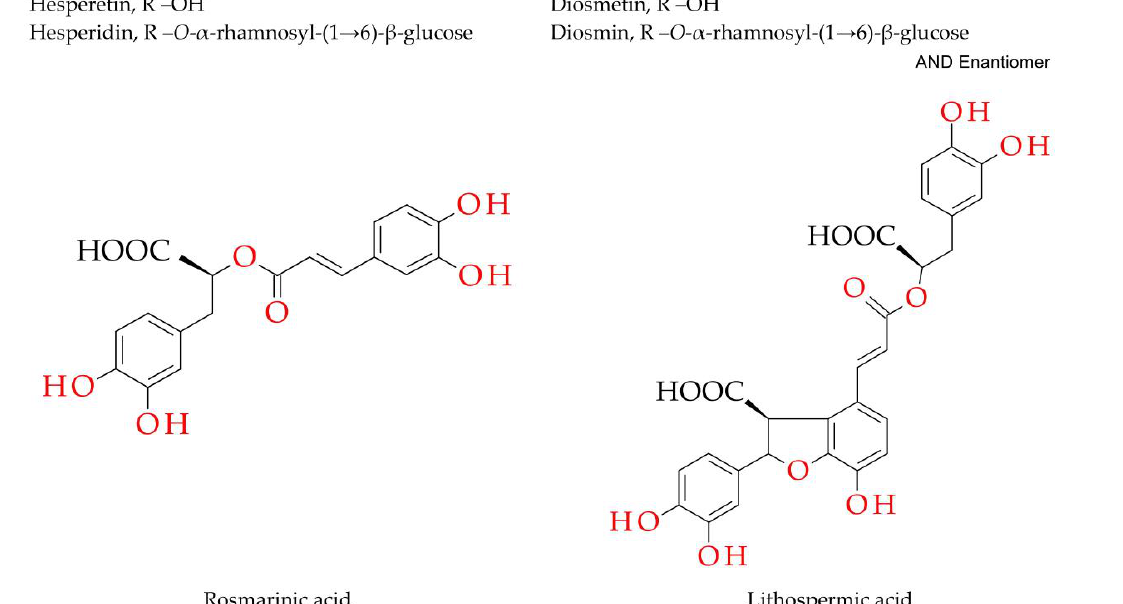
Figure 1. Structures of peppermint polyphenols.